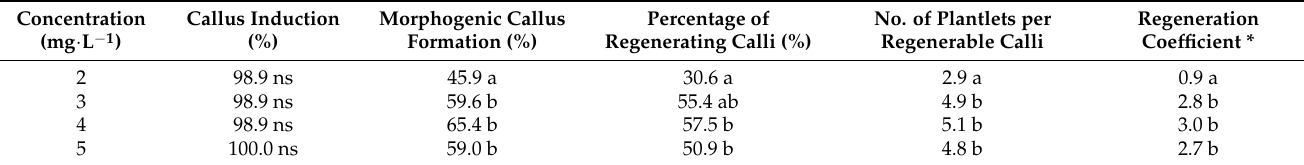
Table 3. The effect of Picloram concentrations on morphogenic callus production and plant regenera- tion in immature embryo-derived cultures of Triticum urartu , spring accession